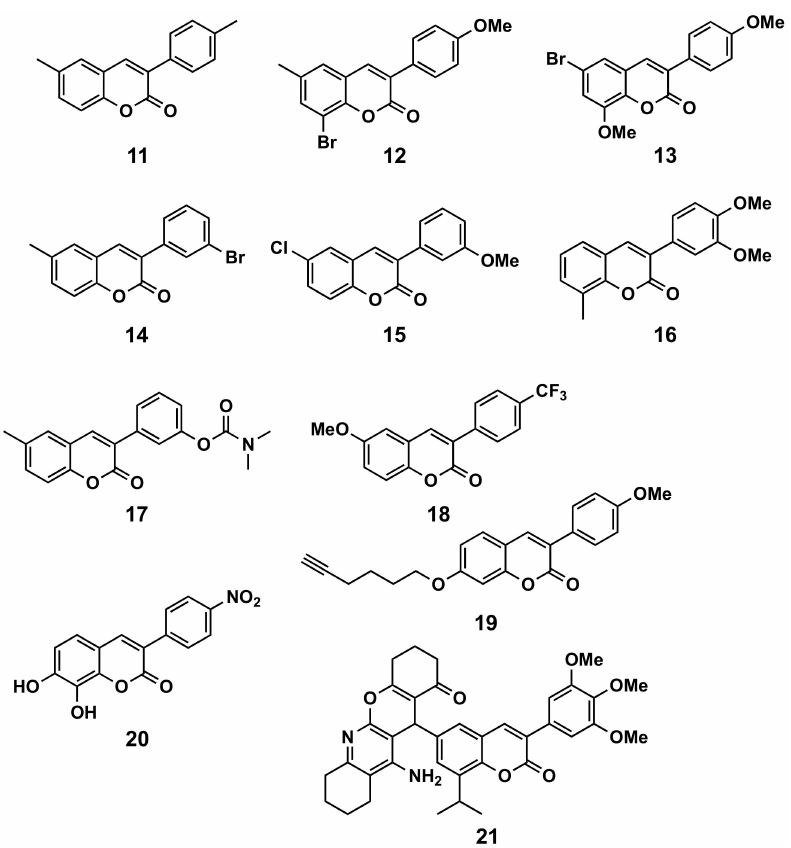
Figure 12. 3-Phenylcoumarins in Parkinson’s disease: MAO-B